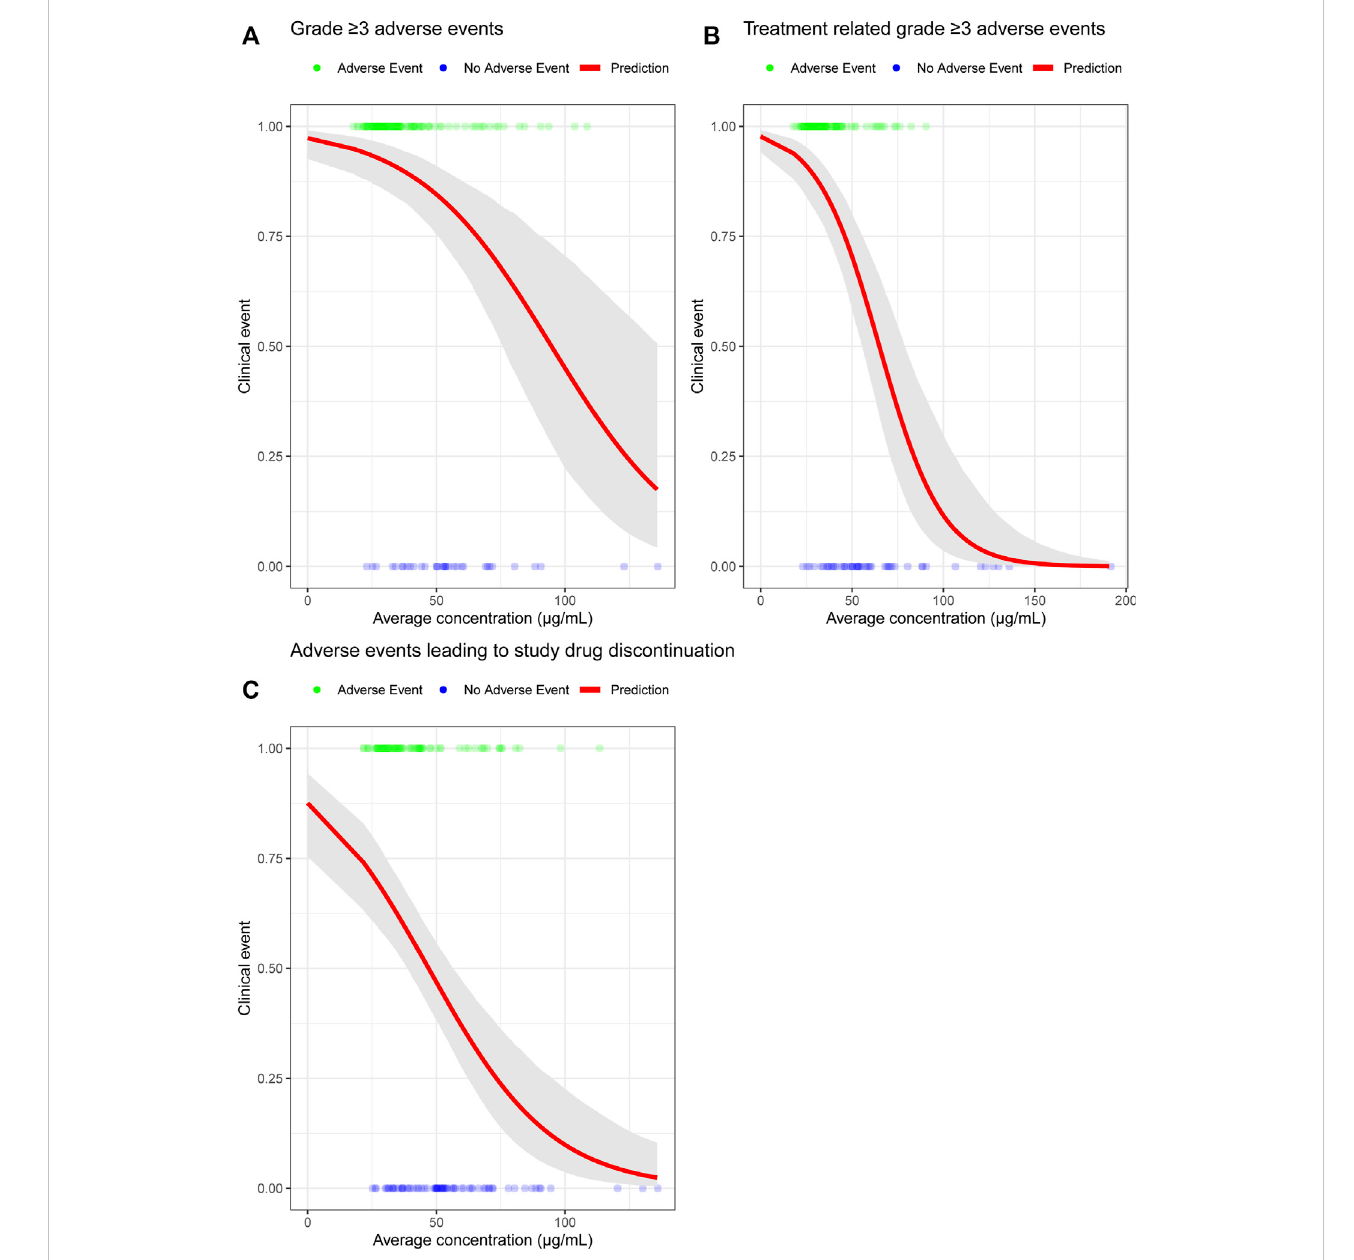
FIGURE 3 (A) Probability of grade ≥ 3 AEs exposure-response model for toripalimab combination therapy. (B) Probability of treatment-related grade ≥ 3 AEs exposure-response model for toripalimab combination therapy. (C) Probability of AEs leading to study drug discontinuation exposure-response model for toripalimab combination therapy. The solid red line is the predicted probability of experiencing three different categories of adverse events. The gray-shaded area is the 95% CI of the model prediction. Abbreviation: CI = con fi dence